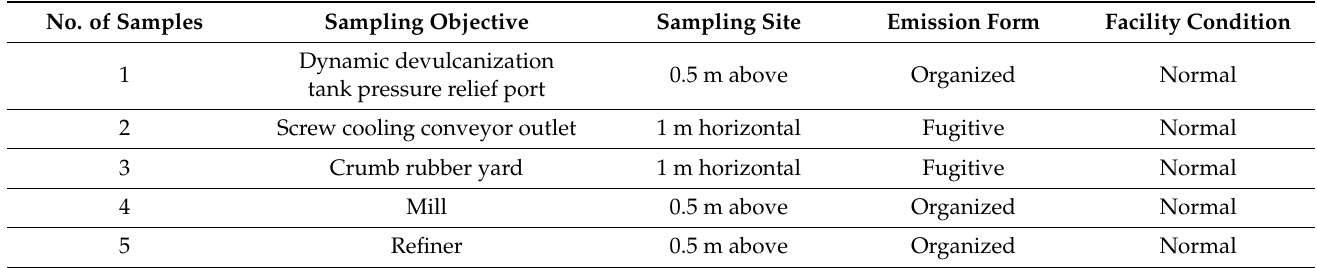
Table 1. Sampling information in each measured sample ( µ g/m 3